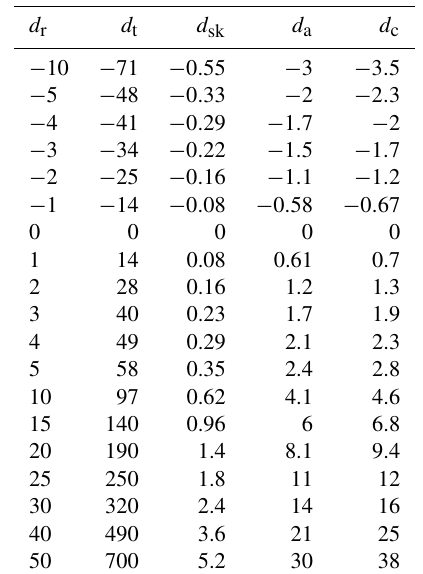
Table 1. Conversion table for the different discordance filters, con- structed using the test data. All discordance values are expressed as percentages, except for d t , which is expressed in Myr. This table al- lows the reader to select a discordance cutoff that removes the same fraction of their data as the relative age cutoff ( d r ) that they may have applied in the